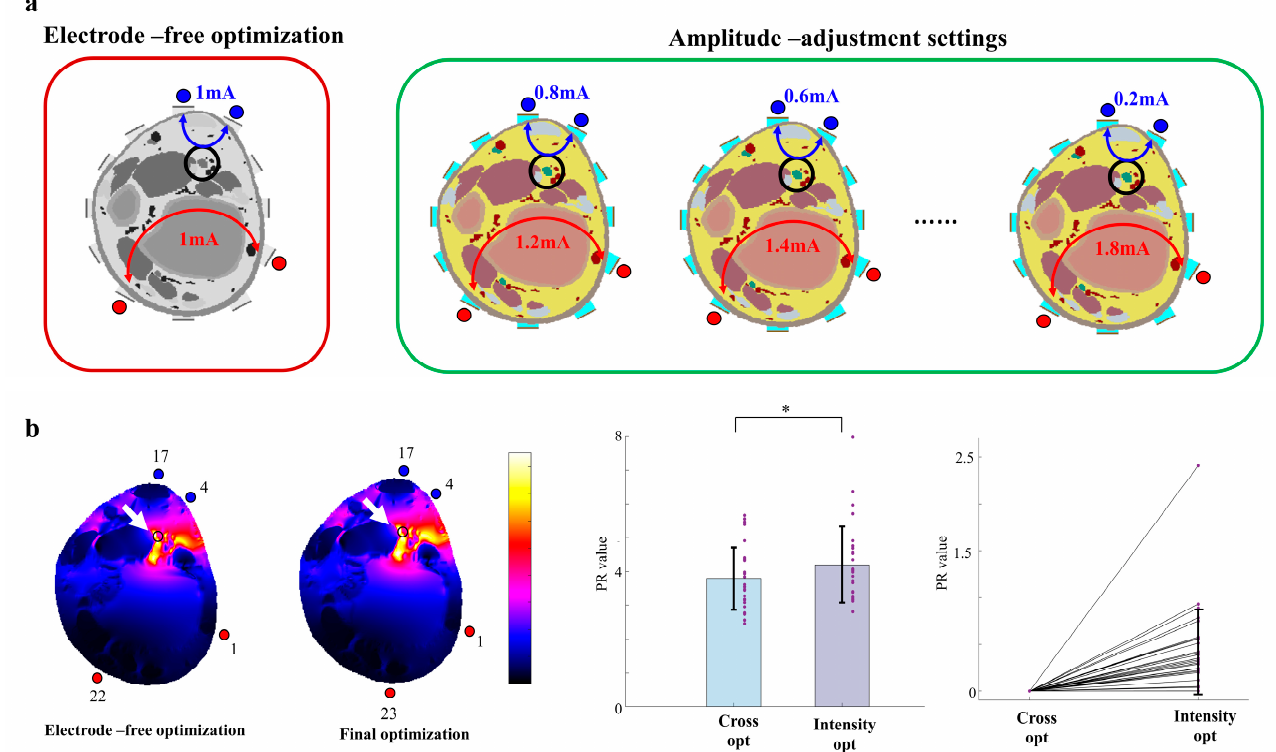
Figure 5. Comparison of TI stimulation results in electrode-free optimization and final optimization. ( a ) Concept of electrode-free optimization and amplitude-adjustment settings. ( b ) Comparison of cross opt TI and intensity opt TI results, * p < 0.0001. Table 4. Optimization parameter settings for intensity opt TI.